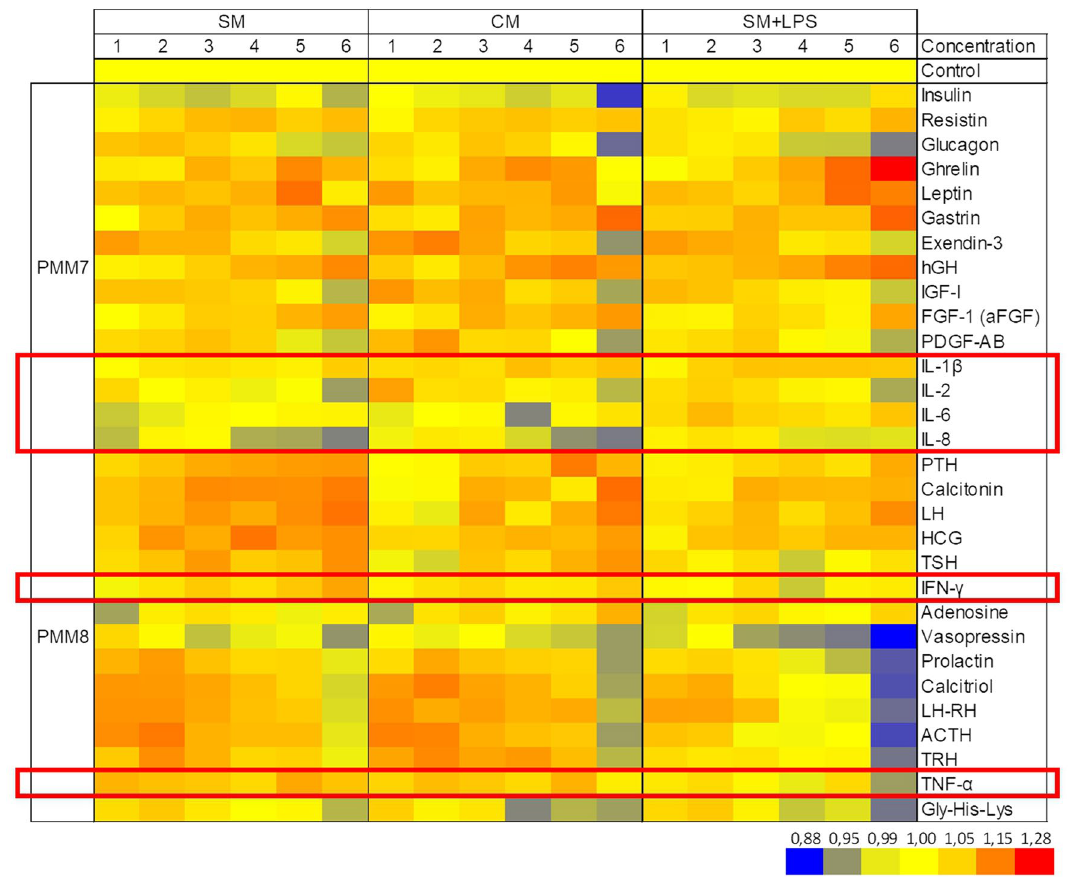
Figure 4. Heatmap of fold change in Phenotype MICROARRAYS for mammalian cells, PMM7 and PMM8—“MICROPLATE—Hormones & Metabolic Effectors” in examined groups. SM standard medium, C M conditioned medium from ADSC, SM + LPS standard medium with the addition of 2 µg/ml of LPS. Red— highest values, blue—lowest values, yellow—neutral. Cytokines are marked with red frame. This heatmap was created with MS Excel 2019